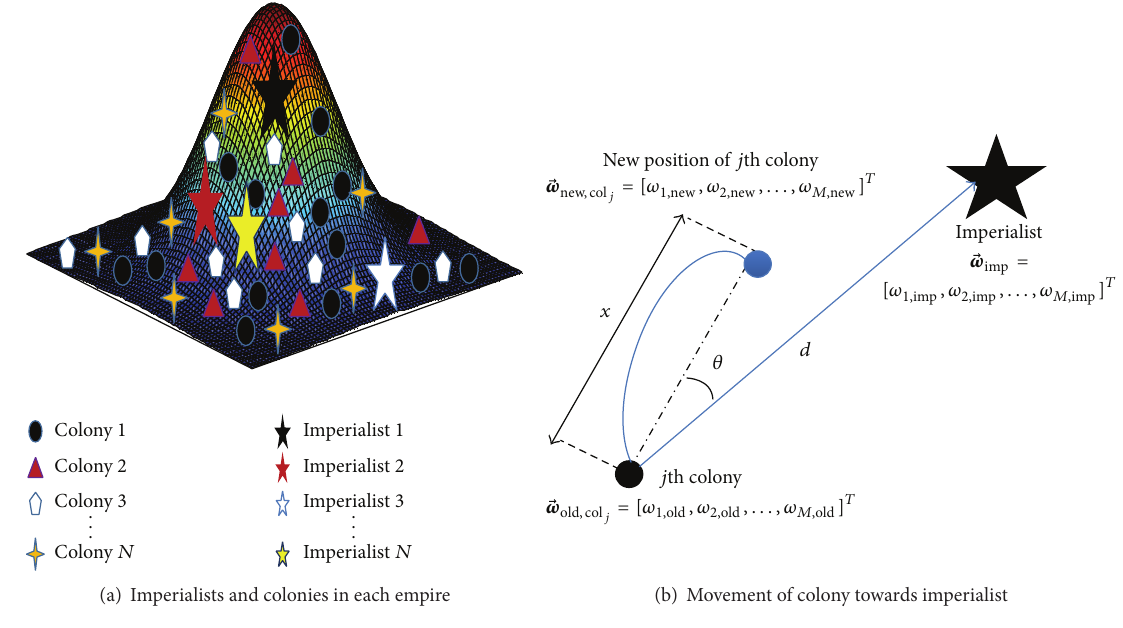
Figure 2: Current and future position of imperialists and colonies in imperialistic competitive algorithm.